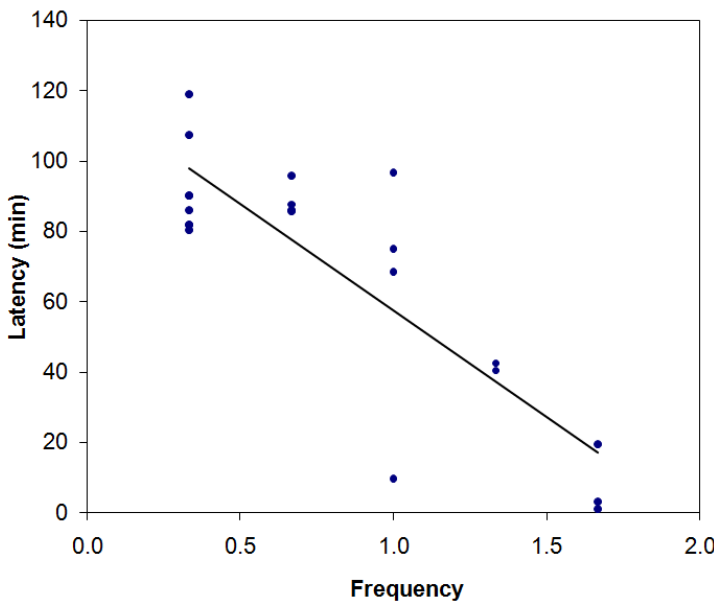
Figure 7. Negative correlation between the mean frequency and the latency for entry into the boxes at the two available heights (0.0 m and 0.5 m). r = − 0.71, p = 0.0003. Spearman’s coefficient.